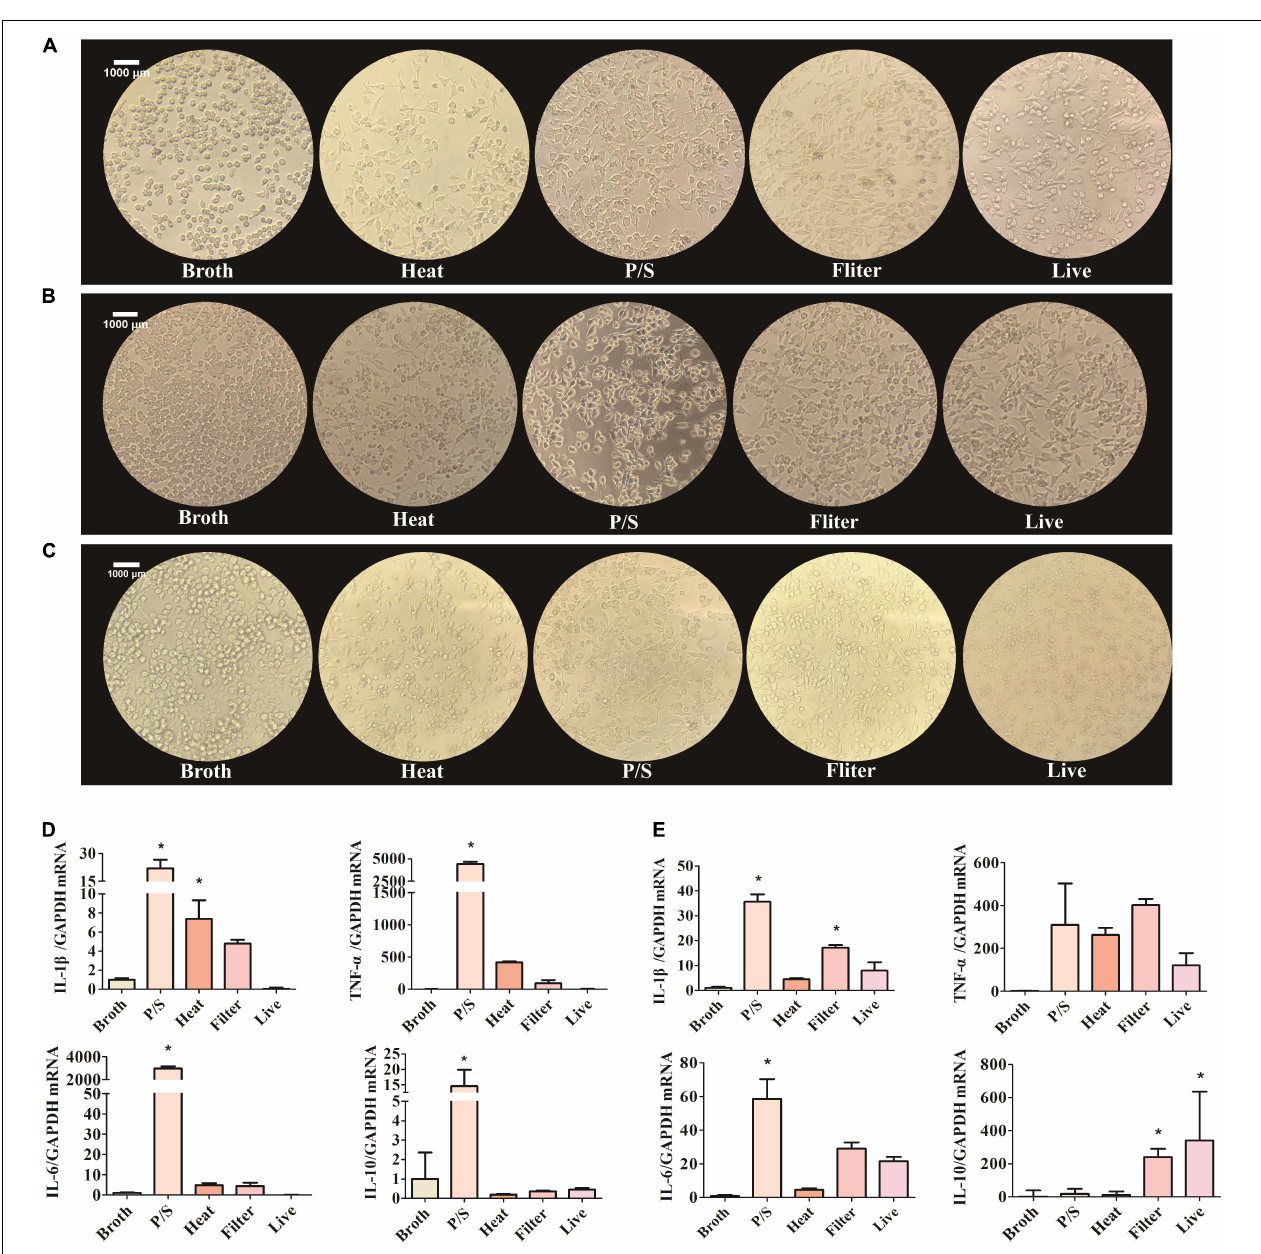
FIGURE 2 | F. nucleatum could activate the SIM-A9 cells in vitro. (A–C) The morphological changes of SIM-A9 cells after co-culturing with F. nucleatum for (A) 5 h, (B) 24 h and (C) 48 h. (D,E) The expression level of genes of inflammatory factors from SIM-A9 after co-culturing with F. nucleatum for (D) 5 h and (E) 12 h. All data were expressed as mean ± SD. *P < 0.05 vs. Broth